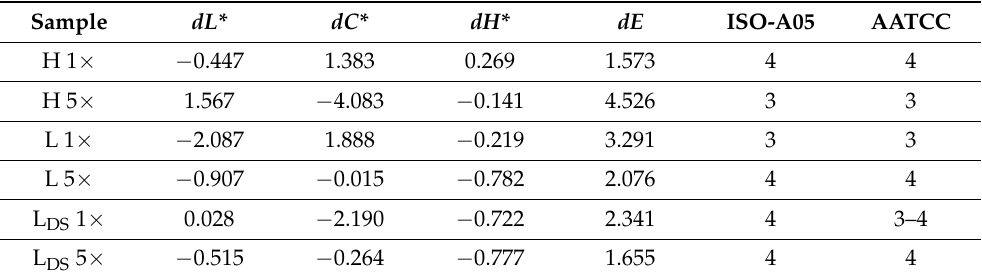
Table 2. Average values of spectral properties of the front surface of medical masks after the first and fifth washing cycle compared to the unwashed